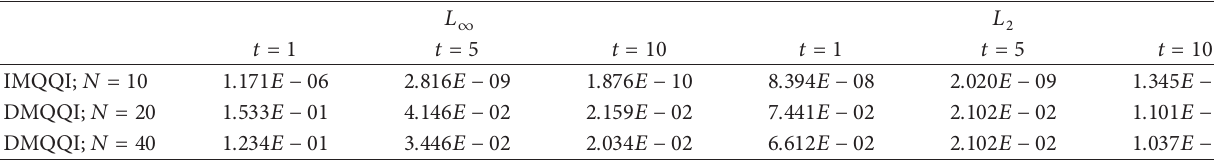
Table 7: The comparison of 𝐿 2 and 𝐿 ∞ errors between the numerical results of our schemes with Δ𝑡 = 0.01 of Experiment 4. 𝐿